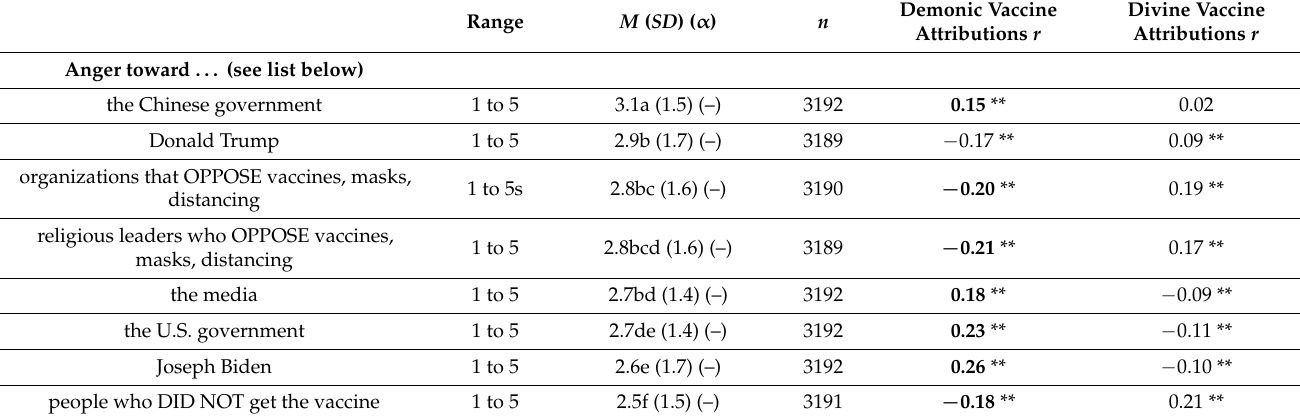
Table 3. Anger toward Others in Response to the Pandemic: Descriptive Statistics and Correlations with Demonic and Divine Vaccine